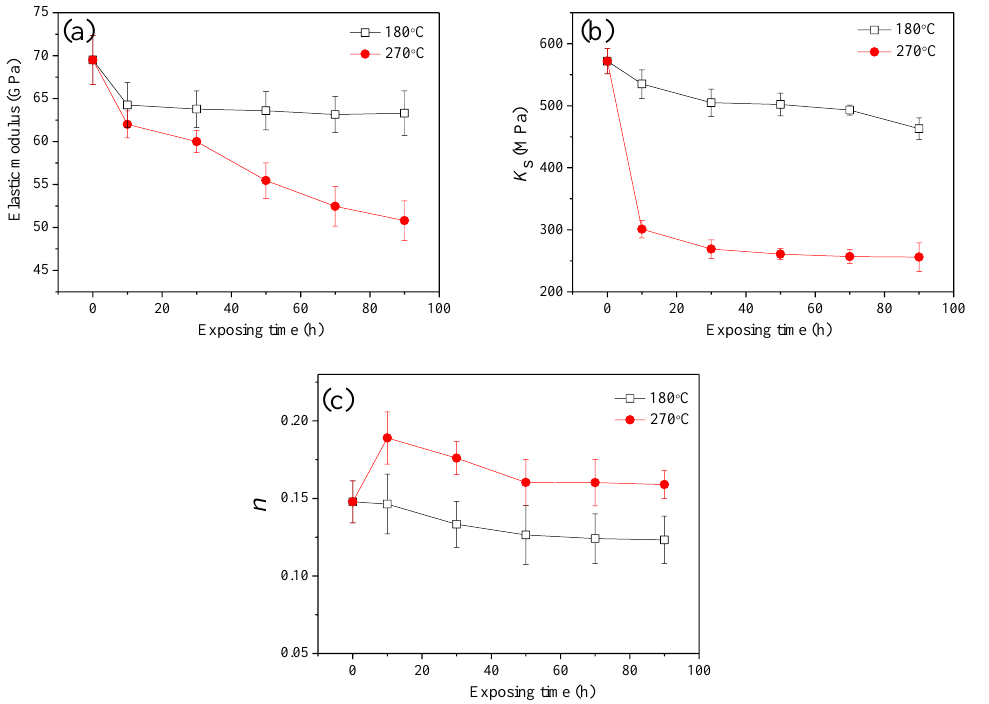
Figure 4. Parameters (elastic modulus, K s and n ) of the studied alloy vs exposing time: ( a ) elastic modulus, ( b ) K s and ( c ) n .